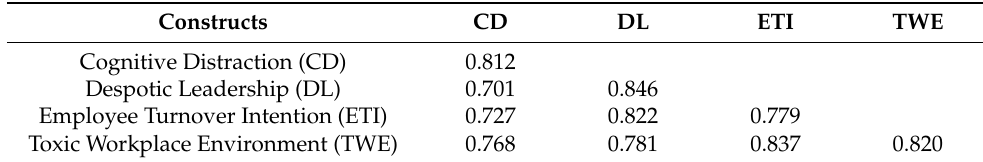
Table 3. Discriminant validity (HTMT).